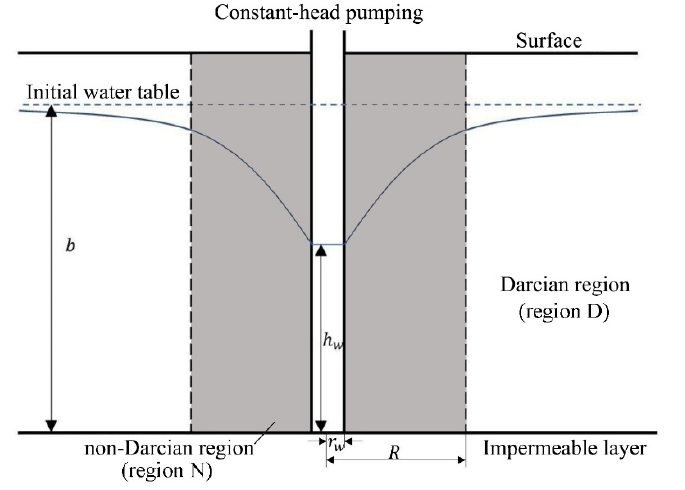
Figure 1. Schematic of the constant-head test in an unconfined aquifer considering the two-region